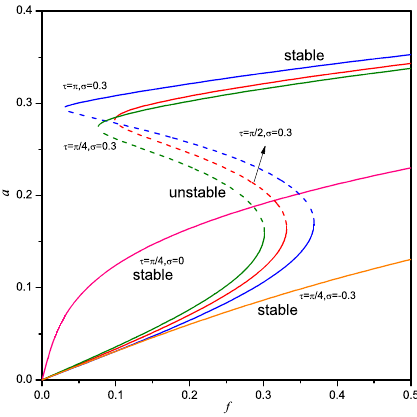
Figure 13. Amplitude of the response as a function of amplitude of the excitation for several detunings.